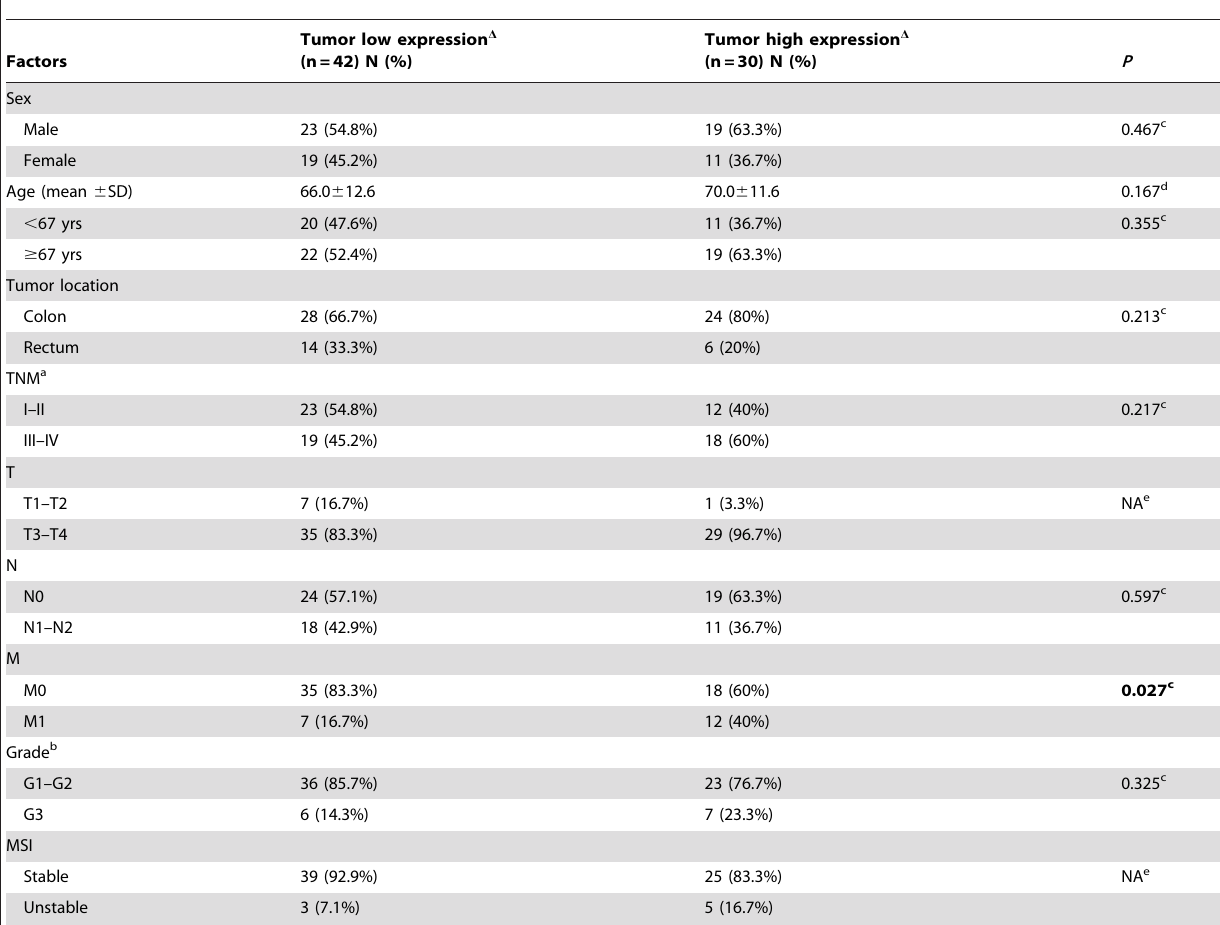
Table 1. Clinicopathological characteristics and 91H expression of CRC patients.